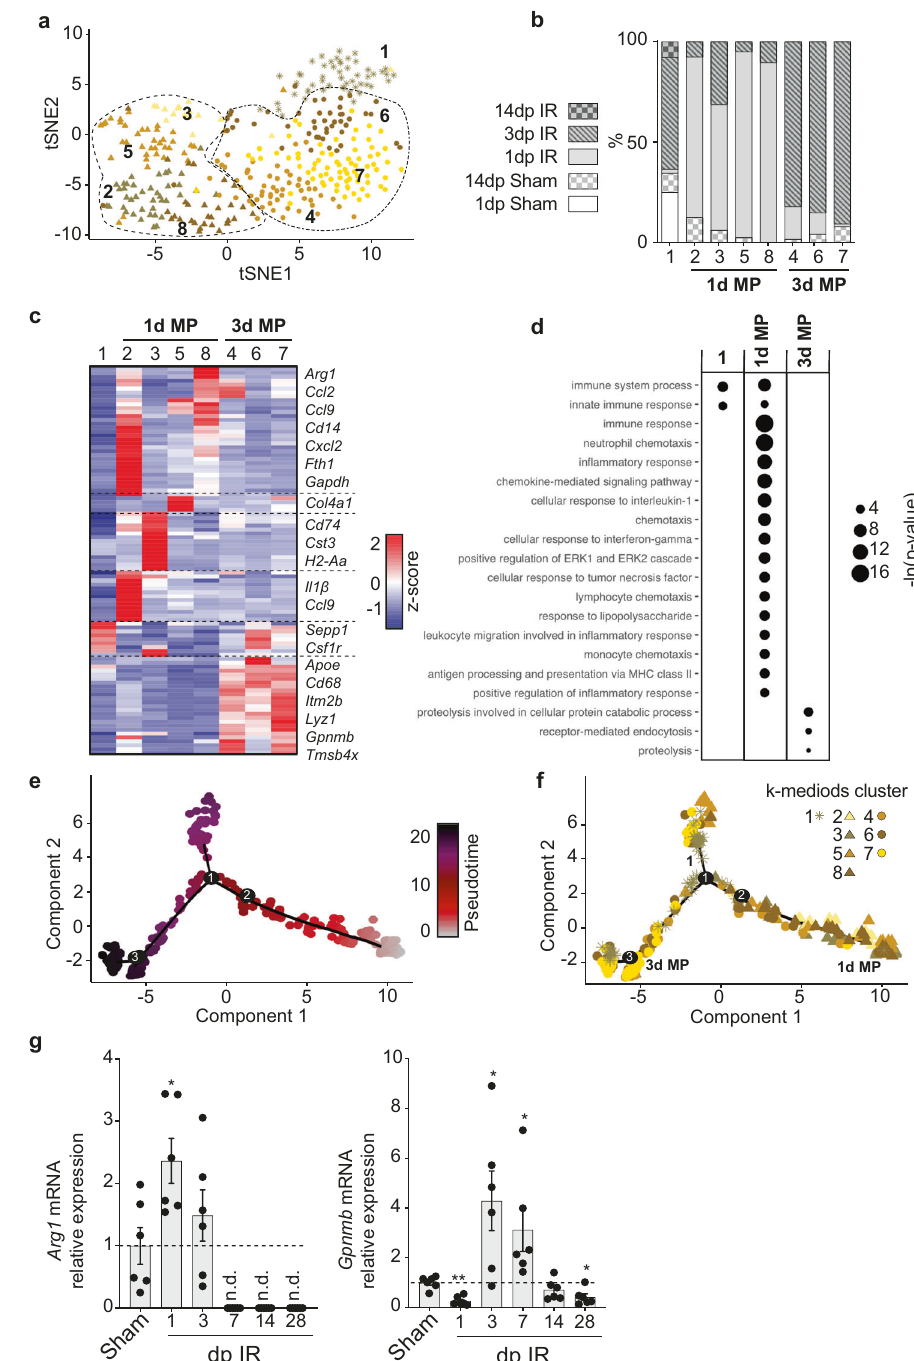
Fig. 3 Macrophages show transcriptional heterogeneity after ischemia and shift from a pro-in fl ammatory to a wound healing transcriptional pro fi le. a tSNE plot indicating transcriptomic similarities across macrophages obtained from all conditions. Different colors, symbols and numbers highlight the clusters as determined by k-medoids clustering of 1 − Pearson ’ s correlation coef fi cient. Stars highlight a cell cluster formed by macrophages from all conditions; triangles highlight clusters containing mainly 1 dp IR macrophages and circles depict clusters containing mainly 3 dp IR macrophages. b Bar graph showing the proportion of macrophages originating from the different conditions per cluster. c Heatmap showing expression of all genes signi fi cantly enriched in at least one cluster. Examples of genes enriched per cluster are depicted on the right side of the heatmap. d Bubble plot of top GO terms in gene ontology analysis on genes signi fi cantly enriched within either cluster one, in at least one of the 1 dp IR enriched clusters or in at least one of the 3 dp IR clusters. e, f Cell trajectory analysis of macrophages, showing pseudotime on a color-coded scale ( e ) or highlighting the k-medoids cluster of each macrophage in the trajectory plot ( f ). The branches in the trajectory plot that contain mostly cells from cluster 1, from the 1 dp IR clusters or from the 3 dp IR clusters are highlighted by number or tekst. g RT-qPCR analysis on the infarcted cardiac tissue at different time points post IR for Arg1 and Gpnmb . Per time point post IR, expression levels are relative to the corresponding time point post sham surgery ( n = 6 animals). Data are presented as mean ± SEM. * P < 0.05, ** P < 0.01, Two-sample t -test vs corresponding time point post sham, with Holm – Sidak adjustment for multiple comparisons. n.d. not